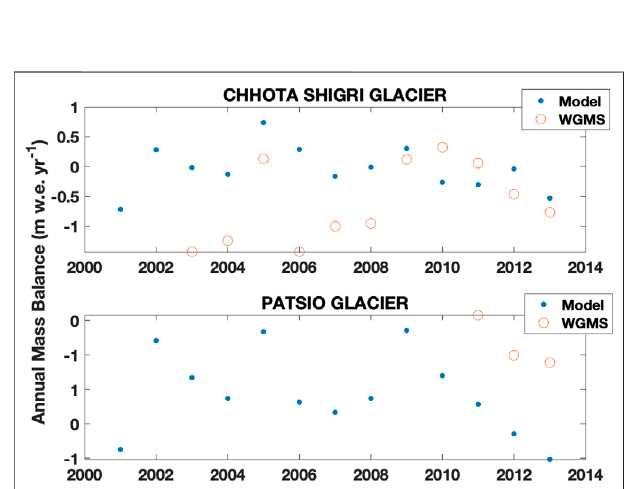
FIGURE 6 | Time series of modeled (2001 – 2013) and measured annual mass balance measurements for Chhota Shigri glacier (2003 – 2013) and Patsio glacier (2011 – 2013), the only two glaciers in the UIB that have annual mass balance data in the WGMS